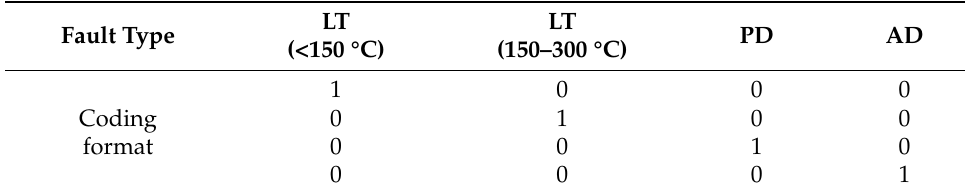
Table 3. Coding format for four types of